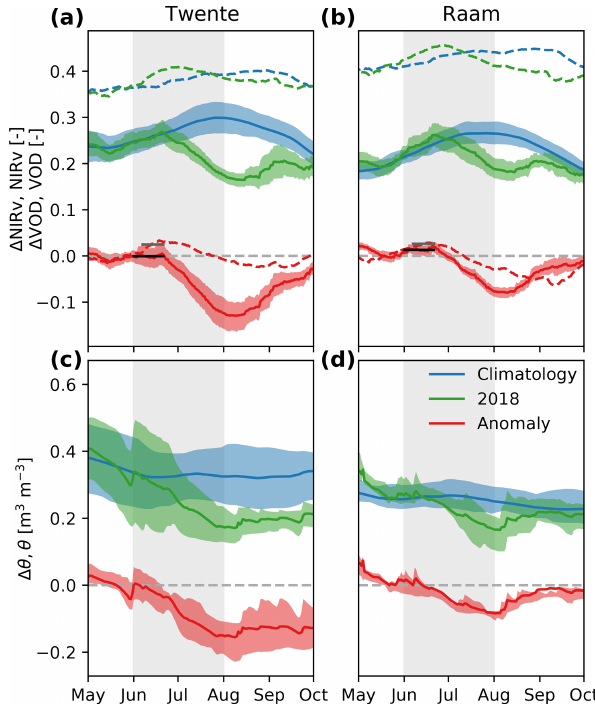
Figure 2. Temporal evolution of the 2018 agricultural drought over the study regions. Panels (a, b) show NIRv (solid) and VOD (dashed), and (c, d) the soil moisture conditions over the growing season for Twente (a, c) and Raam (b, d) . Soil moisture is the av- erage observed at 40cm depth. Horizontal lines in panels a and b indicate the non-stressed NIRv (black) and VOD (grey) values used in Fig. 3. Coloured shaded areas represent spatial variability within the regions and are calculated in the 20%–80% range. Grey shad- ing highlights the period used in Fig.